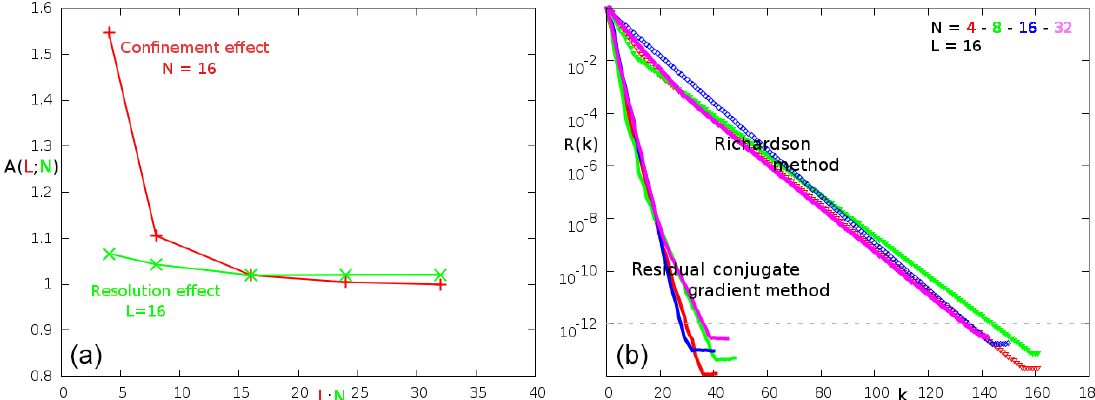
Figure 9. Potential flow around a cylinder: (a) velocity convergence of two iterative methods (residual conjugate gradient, Richardson) for different spatial resolutions N = [ 4 : 32 ] ( L = 16); (b) evolution of the added mass coefficient A(N ; L) with the confinement L = L cyl /R cyl ( N = 16) and with the node number per radius cylinder N ( L = 16). The confinement is defined in Fig. 9a.